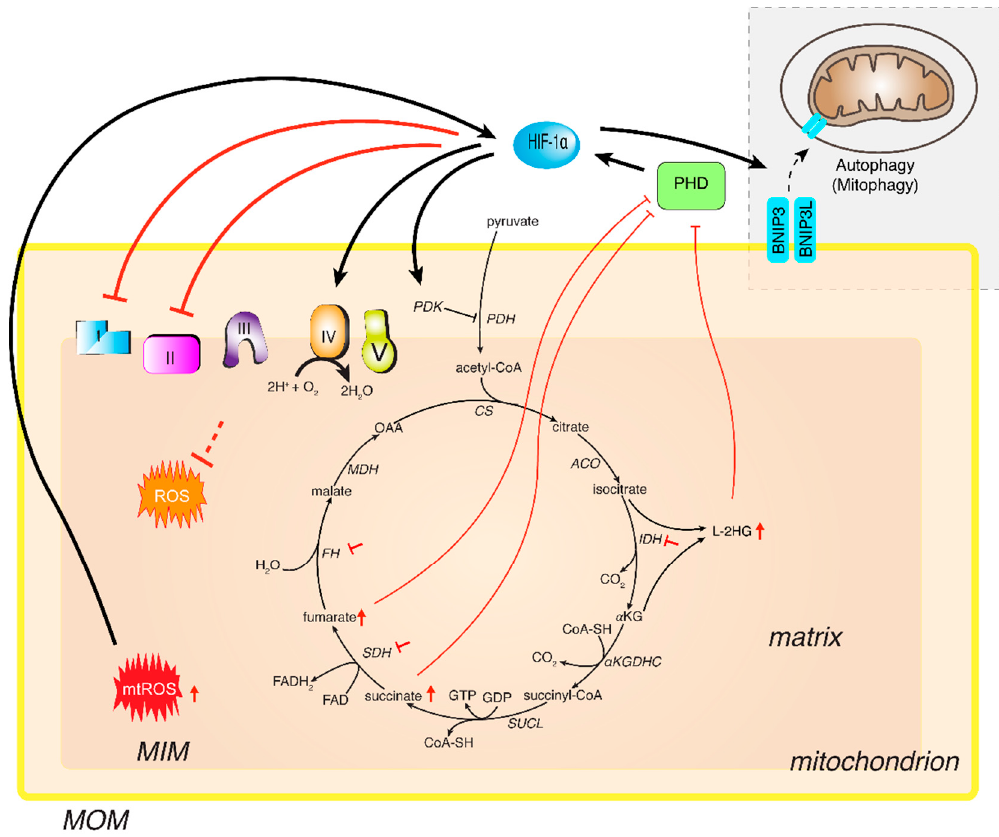
Figure 3. HIF-1 and mitochondrial function. Under hypoxic conditions, cancer cells activate HIF-1, and its interplay with mitochondria is critical for cell survival. HIF-1 α impairs pyruvate conversion to acetyl-CoA by activating pyruvate dehydrogenase kinase (PDK). Two proteins belonging to the BCL2 family of mitochondrial proteins (BNIP3 and BNIP3L) trigger mitophagy following activation by HIF-1. Dysregulation and/or mutations of genes encoding succinate dehydrogenase (SDH), fumarate hydratase (FH), and isocitrate dehydrogenase (IDH) TCA cycle enzymes lead to accumulation of succinate, fumarate, and L-2-hydroxyglutarate (L-2HG), which decrease the activity of PHD, resulting in a stabilization of HIF-1 α subunit. HIF-1 induces a reduction of the mitochondrial Complex I, Complex II, and improves Complex IV activity in transferring electrons to oxygen in hypoxic condition, thereby lowering ROS production and preserving the membrane potential. Mitochondrial ROS (mtROS) activate HIF-1. Abbreviations: CS: citrate synthase; ACO: aconitase; IDH: isocitrate dehydrogenase; α KGDHC: α KG dehydrogenase complex; SUCL: Succinyl-CoA ligase; FH: fumarate hydratase; MDH: malate dehydrogenase; PDH: pyruvate dehydrogenase; PHD: oxygen-dependent prolyl hydroxylase; L-2HG: L-2-hydroxyglutarate; α KG: α -ketoglutarate; Ac-CoA: Acetyl-Coenzyme A.